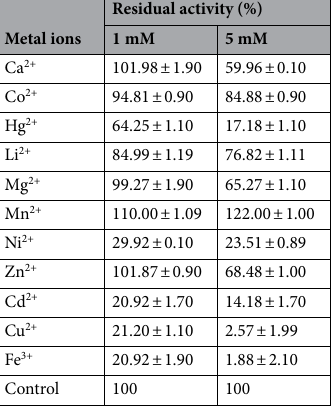
Table 2. Residual activity of SLSP-k with different concentrations of metal